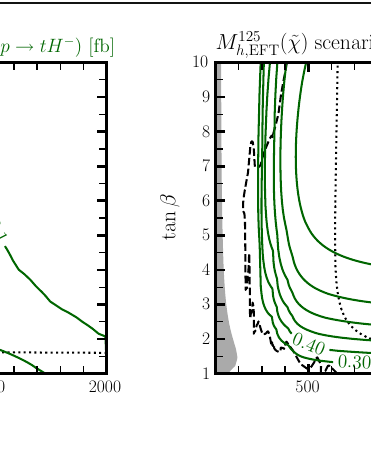
Fig. 9 Branching ratios for the decays of the heavy CP -even Higgs boson H in the M 125 ( upper panels ) and 7 . 5 ( lower panels ). The dominant decays into SM particles ( left panels ) and electroweakinos ( right panels ) are